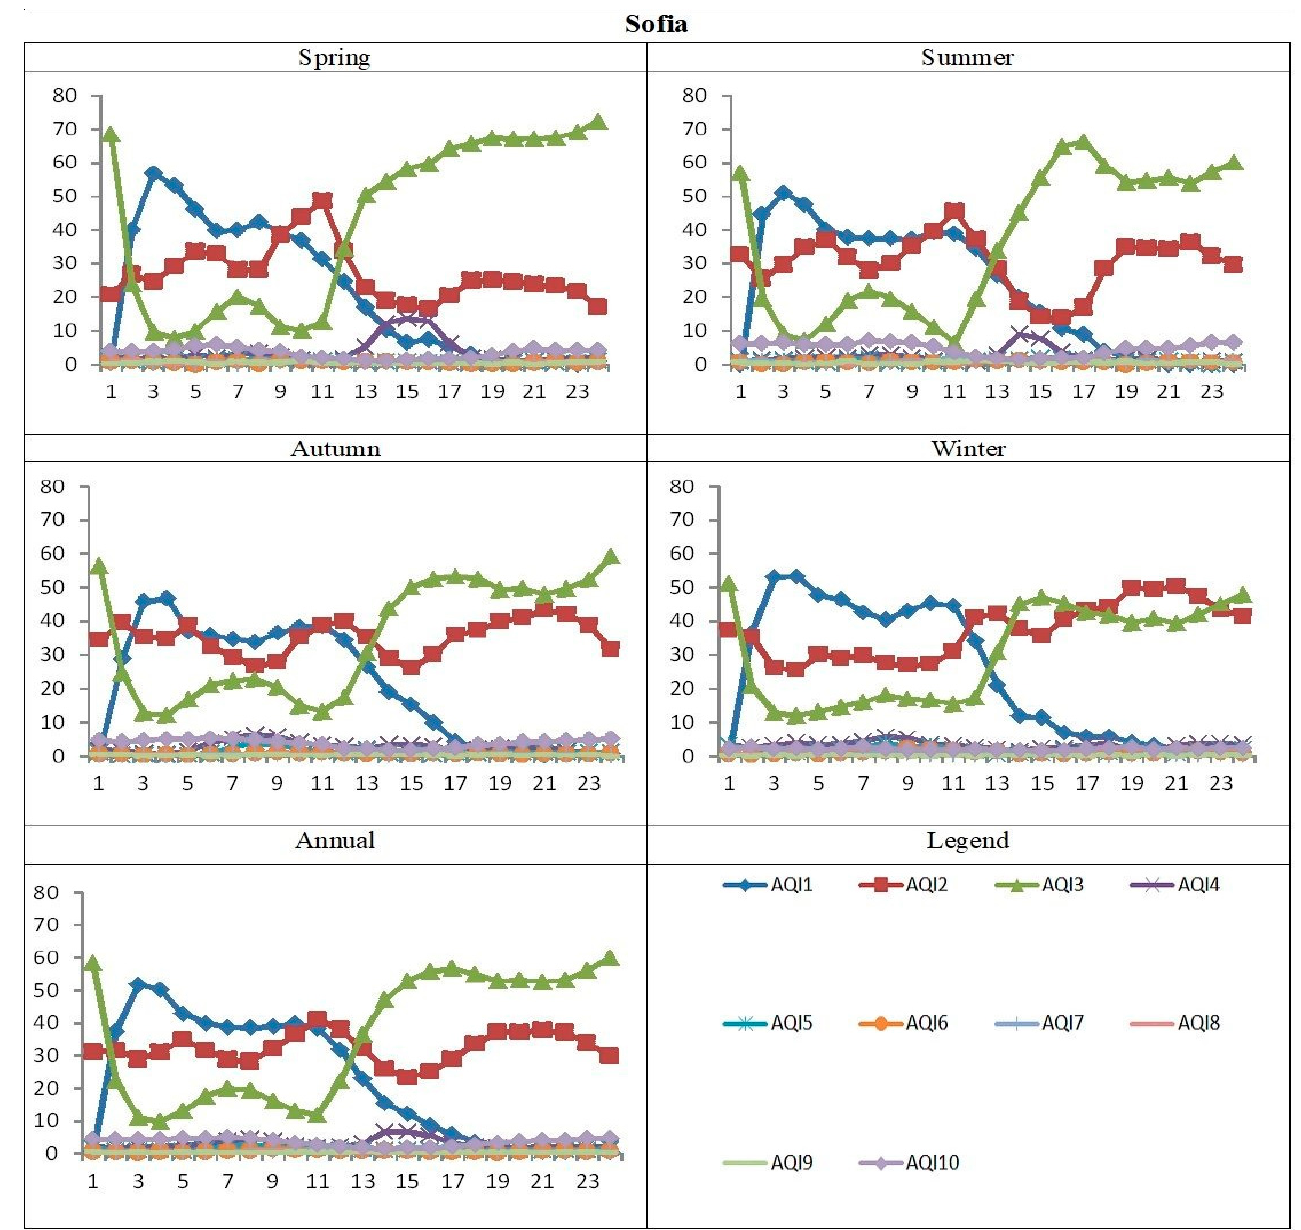
Figure 3. Average recurrence (in %) of the different indices (from 1 to 10) for the territory of the city of Sofia. Figure 4 for the Orlov Most point shows that the indices AQI1, AQI2, and AQI3, which fall in the “Low” interval, have the greatest recurrence during the different seasons. The diurnal course of these indices is well defined. In the morning, AQI1 and AQI2 have a recurrence of about 40%, and in the afternoon, it drops to about 20%. At this time, AQI3 has a minimum recurrence in the morning and a maximum in the afternoon of about 50%. AQI4 has an afternoon maximum of about 10% in the spring and summer. In all the seasons, AQI10 stands out, which corresponds to the “Very High” category and, for this point, has a high repeatability of about